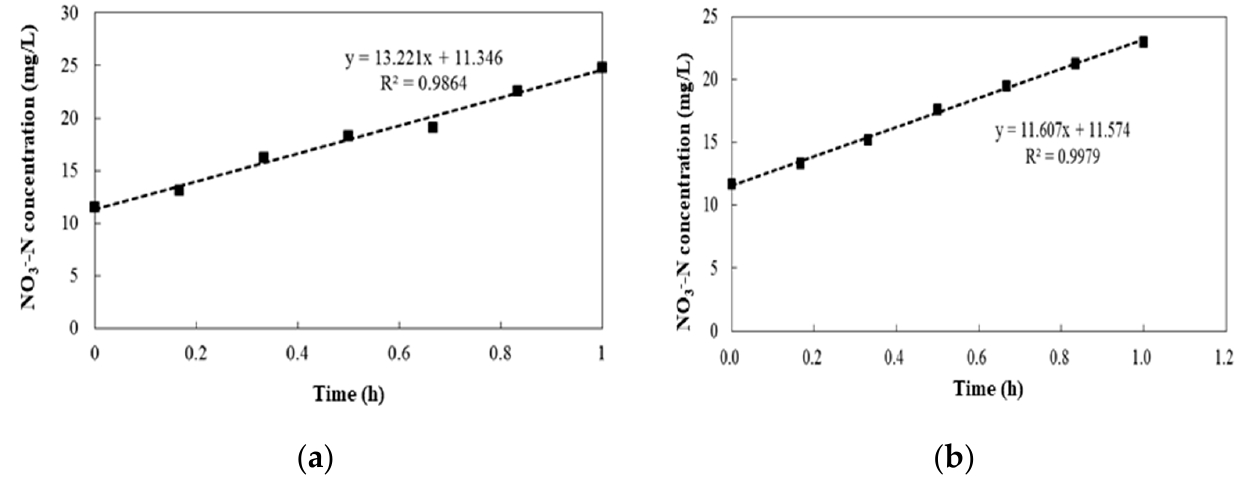
Figure 7. The nitrification rate of activated sludge in the CAST process with different biomass amounts. ( a ): MLVSS of 3500 mg/L; ( b ): MLVSS of 3000 mg/L; average nitrification rate is below 4.0 mg/gVSS·h in China.